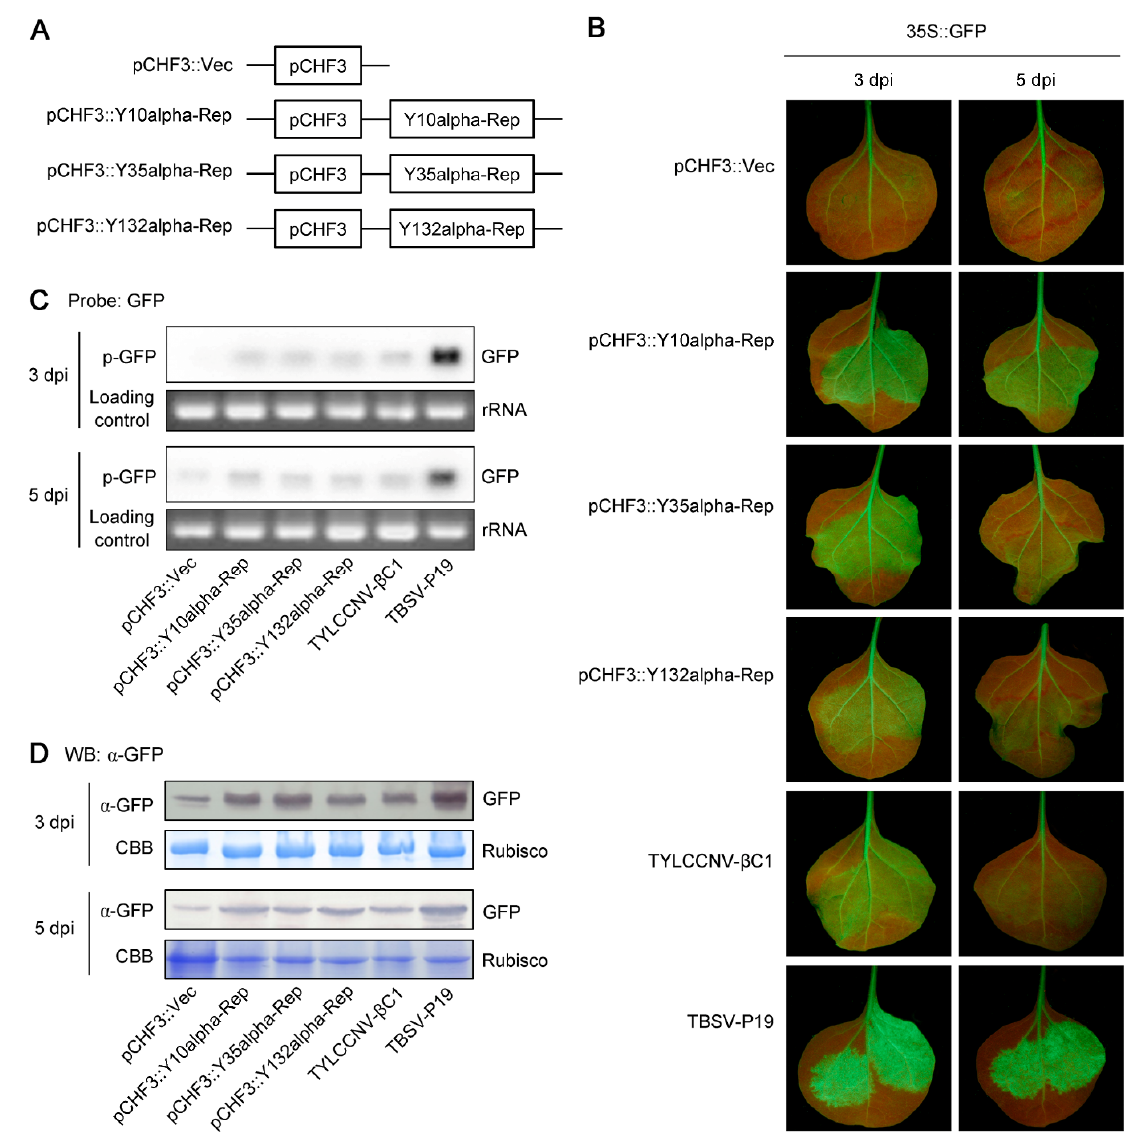
Figure 2. Alpha-Reps suppress the post-transcriptional gene silencing (PTGS) of local GFP. ( A ) Schematic diagram showing the constructs used in the local GFP PTGS assay in panel B. The ORFs of Y10alpha-Rep, Y35alpha-Rep, and Y132alpha-Rep were cloned into the binary vector, pCHF3, to be used for transient expression. An empty pCHF3 vector (pCHF3::Vec) was used as the neg- ative control. ( B ) Suppression of PTGS of GFP in leaves of transgenic N. benthamiana 16c plants. Leaves of 16c plants were coagroinfiltrated with constructs harboring GFP (35S::GFP) and either a pCHF3::Vec, pCHF3::Y10alpha-Rep, pCHF3::Y35alpha-Rep, or pCHF3::Y132alpha-Rep. Leaves of 16c plants coagroinfiltrated with 35S::GFP and TYLCCNV- β C1 or TBSV-P19 were used as the positive controls. The agroinfiltrated leaves were photographed under UV light at 3 and 5 days post infiltration (dpi). ( C ) Northern blot analysis of GFP mRNA accumulation in agroinfiltrated leaf patches shown in panel B. An ethidium bromide-stained gel shown below the blots provides an RNA-loading control. ( D ) Western blot (WB) assay of GFP accumulation in agroinfiltrated leaf patches shown in panel B. CBB staining of the large subunit of Rubisco was used as a loading control. For ( B – D ), the experiments were repeated three times with similar